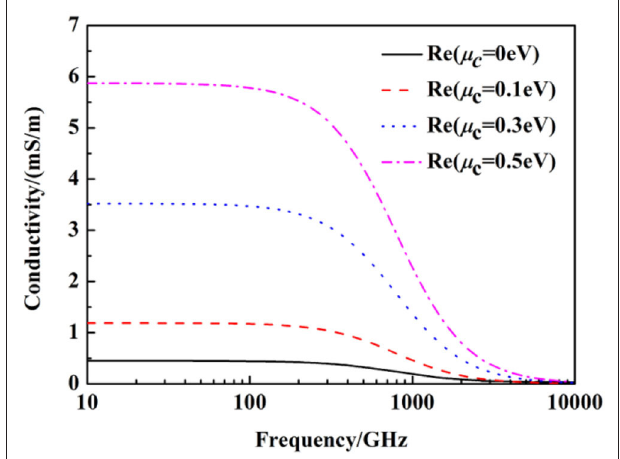
FIGURE 1 | The conductivity of graphene under different Fermi